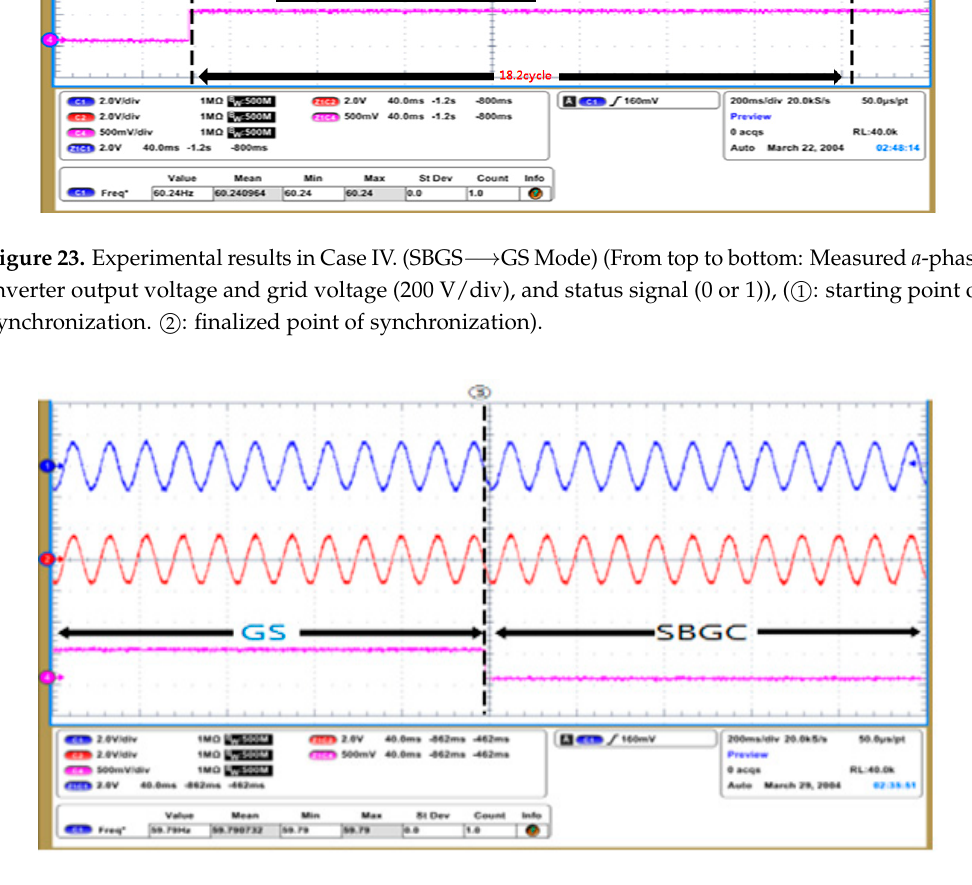
Figure 24. Experimental results when the mode changes from GS to SBGC in Case IV. (From top to bottom: Measured a -phase inverter output voltage and grid voltage (200 V/div), and GS status signal (0 or 1)), ( 3 (cid:13) : GS mode